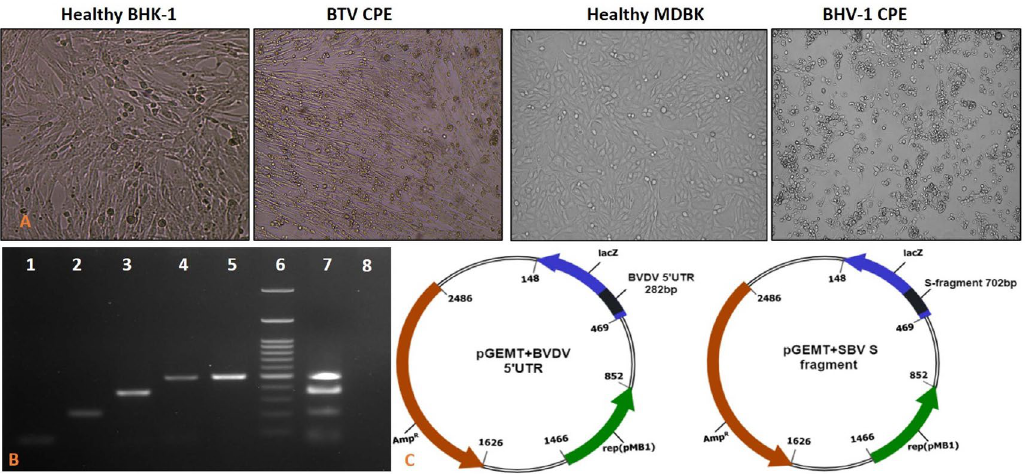
Fig. 1. (A) Propagation of BTV10, and BHV-1 in BHK-21 cells and MDBK cells, respectively. BHV-1 and BTV-10 viruses showed characteristic CPE at 48-72 hpi. (B) Agarose gel (2%) for singleplexed and multiplexed amplicons of abortion causing pathogens. 1- 88bp SBV, 2- 204bp BVDV, 3- 362bp BHV-1, 4- 459bp BTV, 5- 498bp B. abortus , 6- 100bp DNA marker, 7- 88bp SBV; 204bp BVDV; 362bp BHV-1; 459bp BTV; 498bp B. abortus , multiplexed. 8- No template control for multiplexed PCR. (C) A representation of insertion of synthetic gene constructs for BVDV 5´UTR and SBV; S segment in pGEMT vector